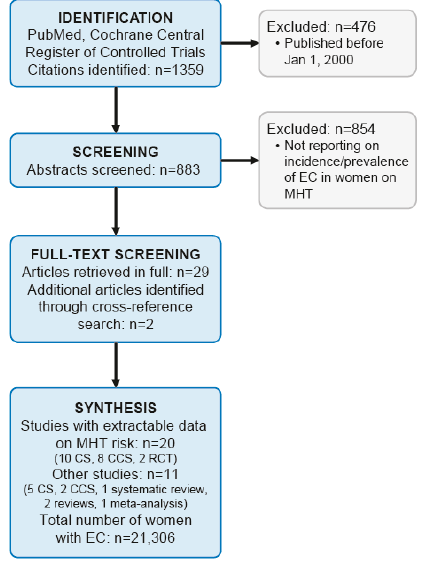
Figure 1. Flow diagram of the literature search